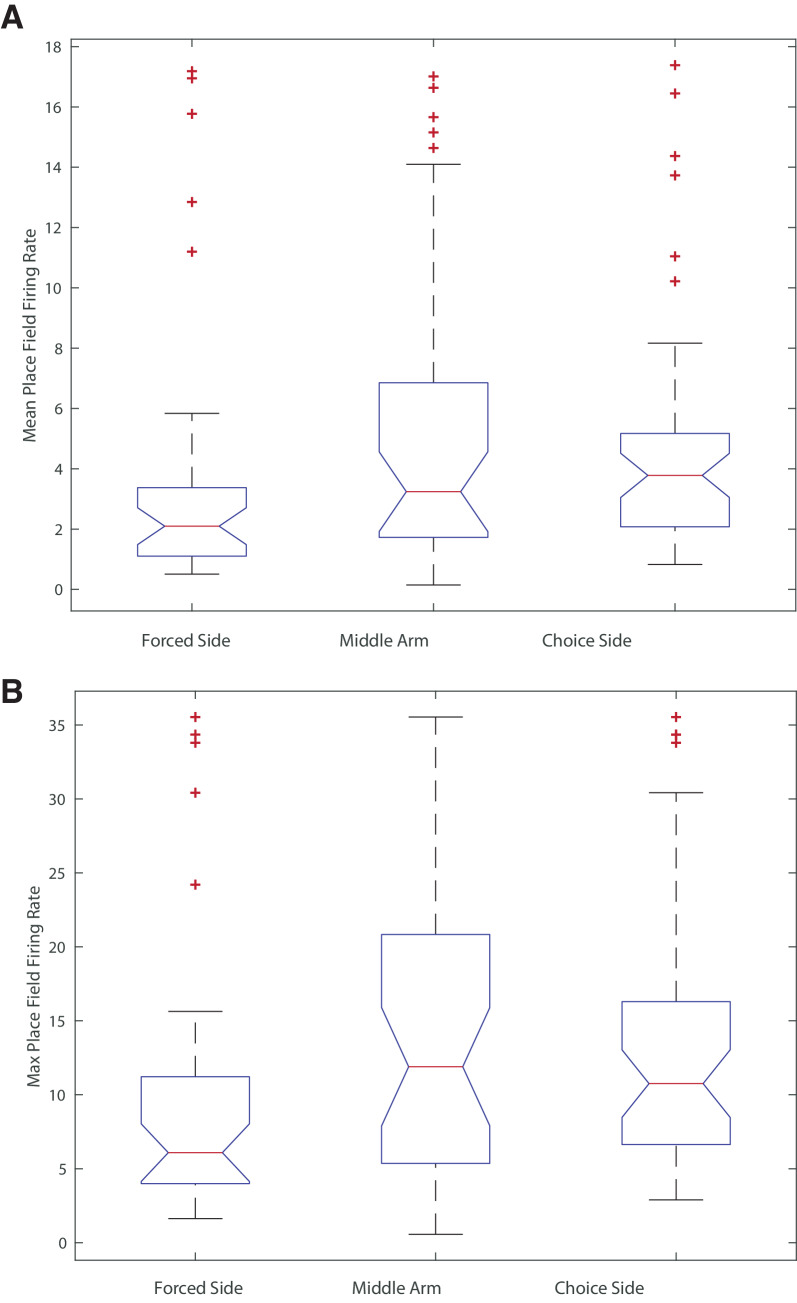
Mean and maximum within-field firing rates for LS place cells based on location.(A) Mean within field firing rates for LS cells with place fields on the forced side, middle arm, and choice side. The means of three distributions were not significantly different (One way anova, F(2,112) = 1.15, p>0.05). (B) Mean within field firing rates for LS cells with place fields on the forced side, middle arm, and choice side. The means of the three distributions were not significantly different (One way anova, F(2,112) = 1.93, p>0.05).